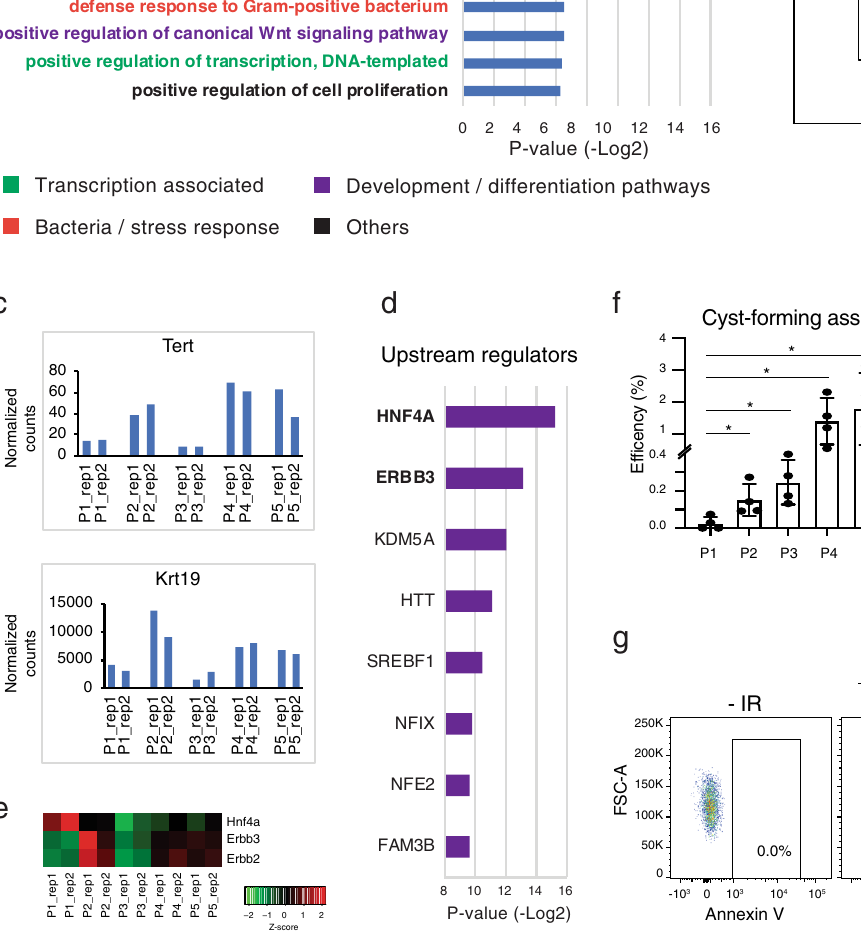
Protein concentration of GST-peptides was determined using SDS-PAGE and Coomassie (Instantblue, Sigma) staining. Kinase assays were performed on 2 μ l GST beads (for short peptide targets and CTD control) or 10 μ g puri fi ed His- tagged fl uorescent protein in 20 μ l buffer volume (20 mM HEPES (pH8), 10 mM MgCl 2 , 1mM DTT, 15 μ M ATP) using 10 μ Ci 32 P-ATP and 50ng active CDK 1, 2, 5, 7, or 9 (Millipore). Reactions were incubated at 30°C for 1h and terminated by boiling in SDS sample buffer for 5min at 95 °C. Samples were run at 150V for 60 – 70min on 12% SDS-PAGE gels and subsequently subjected to Coomassie (Instantblue, Sigma) staining. Gels were dried and autoradiography performed at − 80°C overnight.